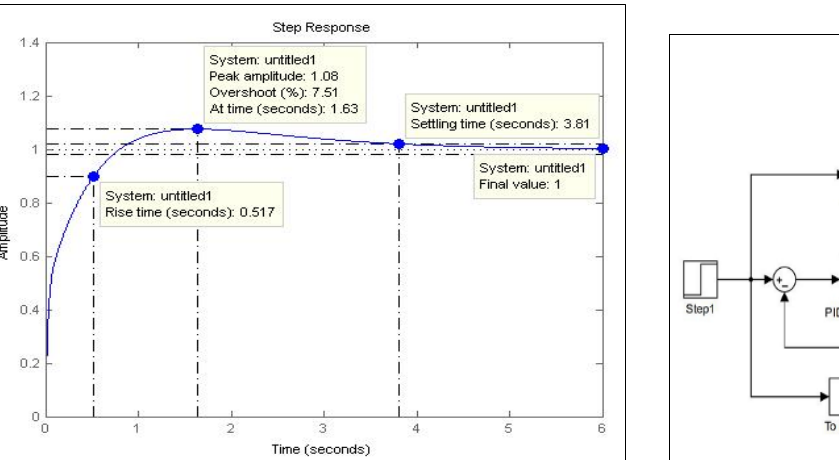
Figure 6: Genetic algorithm simulation model.